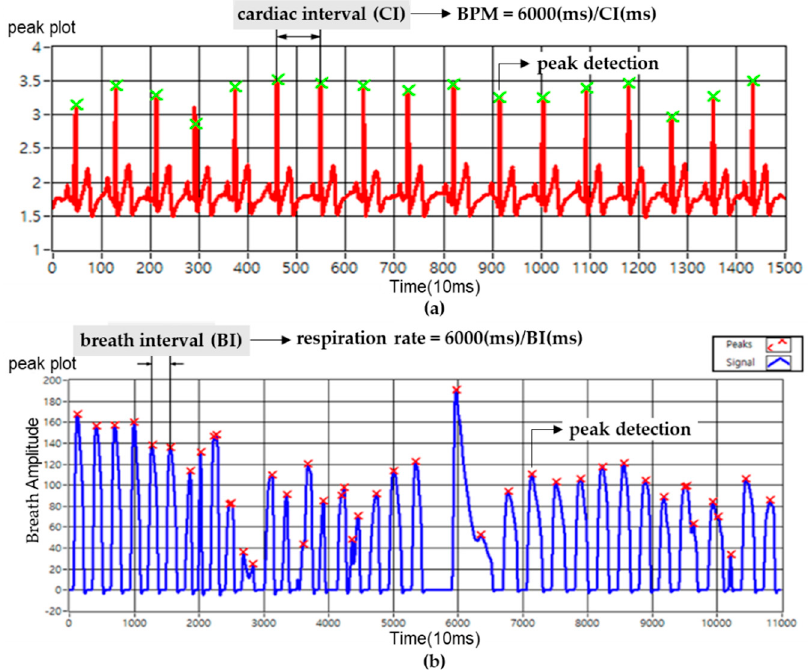
Figure 5. Biosignal acquisition while driving: (a) ECG (electrocardiography) and (b) respiration.